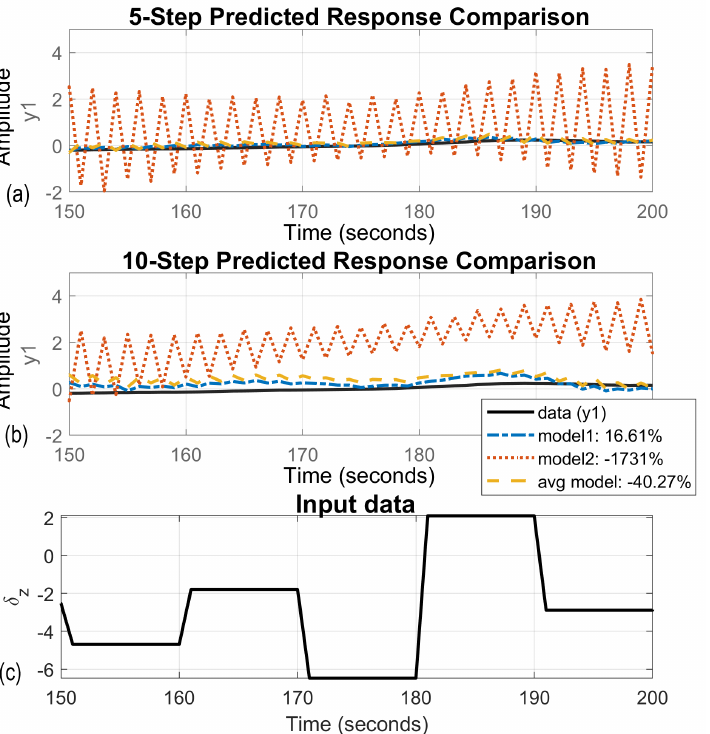
Figure 6. Examples of model predictions based on real-time lake validation data, magnified figure. ( a ) 5-steps ahead prediction, ( b ) 10-steps ahead prediction, ( c ) validation data